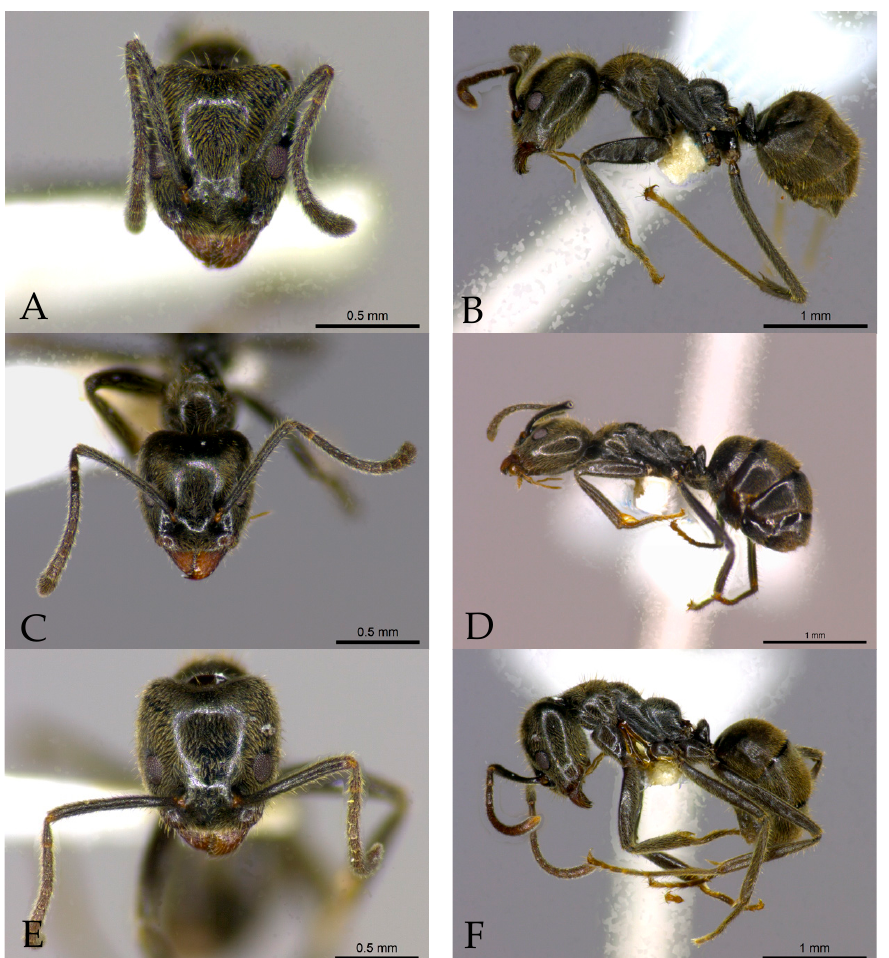
Figure 7. Head and lateral views of Anonychomyrma sp. A ( A , B ), sp. L ( C , D ), and sp. M ( E , F ), which are all closely related to Anonychomyrma gilberti (Figure 1).